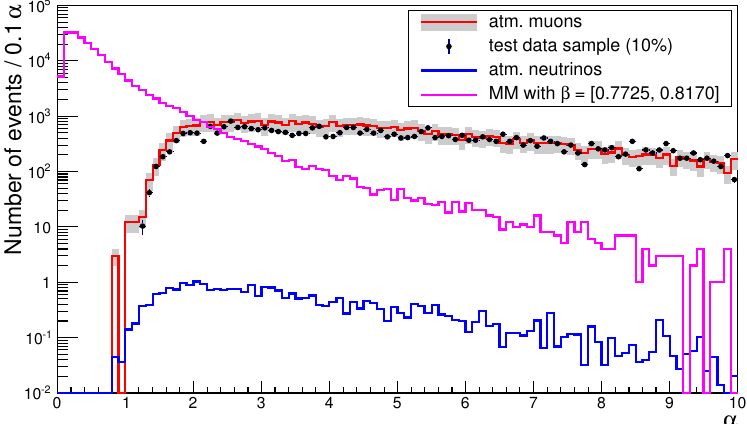
0 α Figure 5 . Distribution of the (cid:11) variable for atmospheric muons (red histogram) with an uncertainty band of 35% ((cid:12)lled in gray), atmospheric neutrinos (blue histogram) and data (points with error bars). For comparison, the distribution of the (cid:11) variable for MMs simulated in the velocity range [0 : 7725 ; 0 : 8170] (magenta histogram) is also shown. Only events with reconstructed velocity (cid:12) (cid:12)t